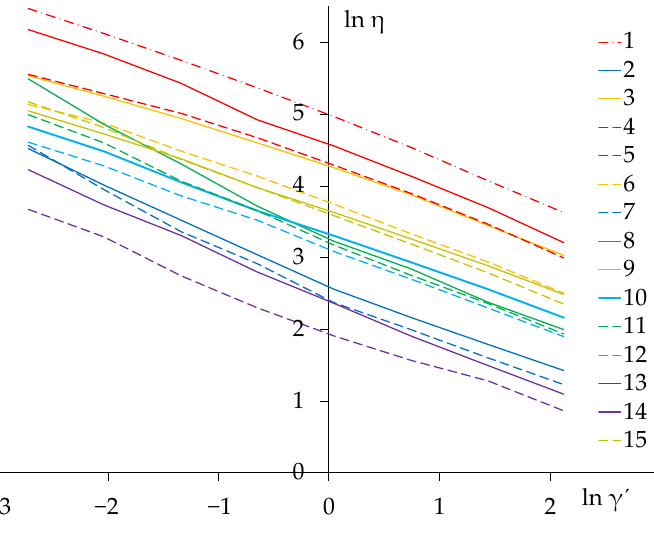
Figure 2. Viscosity curves.